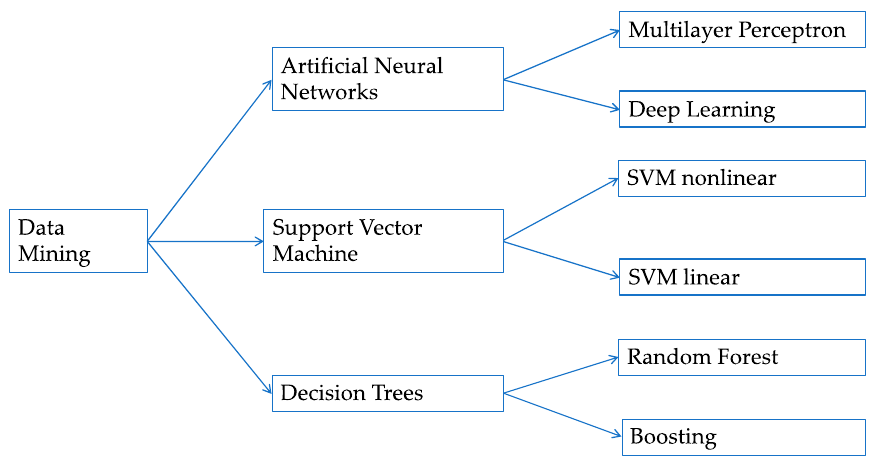
Figure 3. Classification of DM techniques included in this paper.